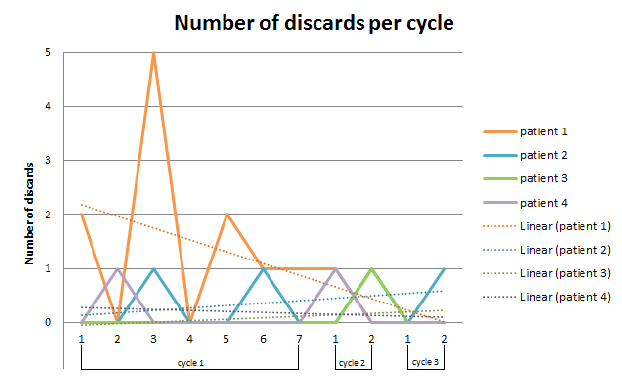
Figure 10: Number of discards made by each participant per cycle